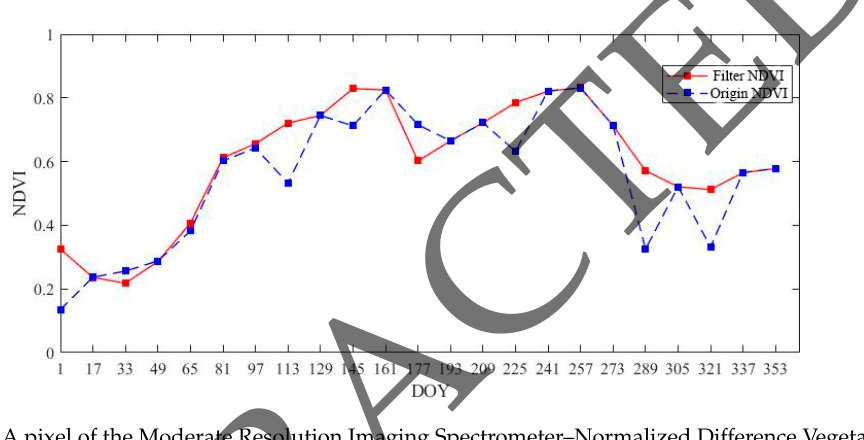
Figure 5. A pixel of the Moderate Resolution Imaging Spectrometer–Normalized Difference Vegetation Index ( MODIS–NDVI) time series after filtering by Savitzky ‐ Golay (S ‐ G).